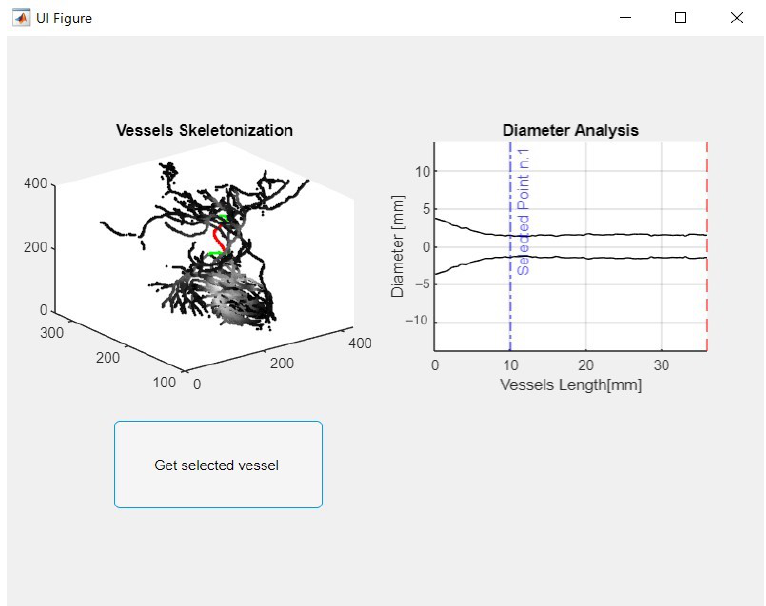
Figure 9. Main window of the system; on the ( left ), 3D plot of the skeletonized vessel tree; on the ( right ), plot of the vessel(s) diameter as a function of